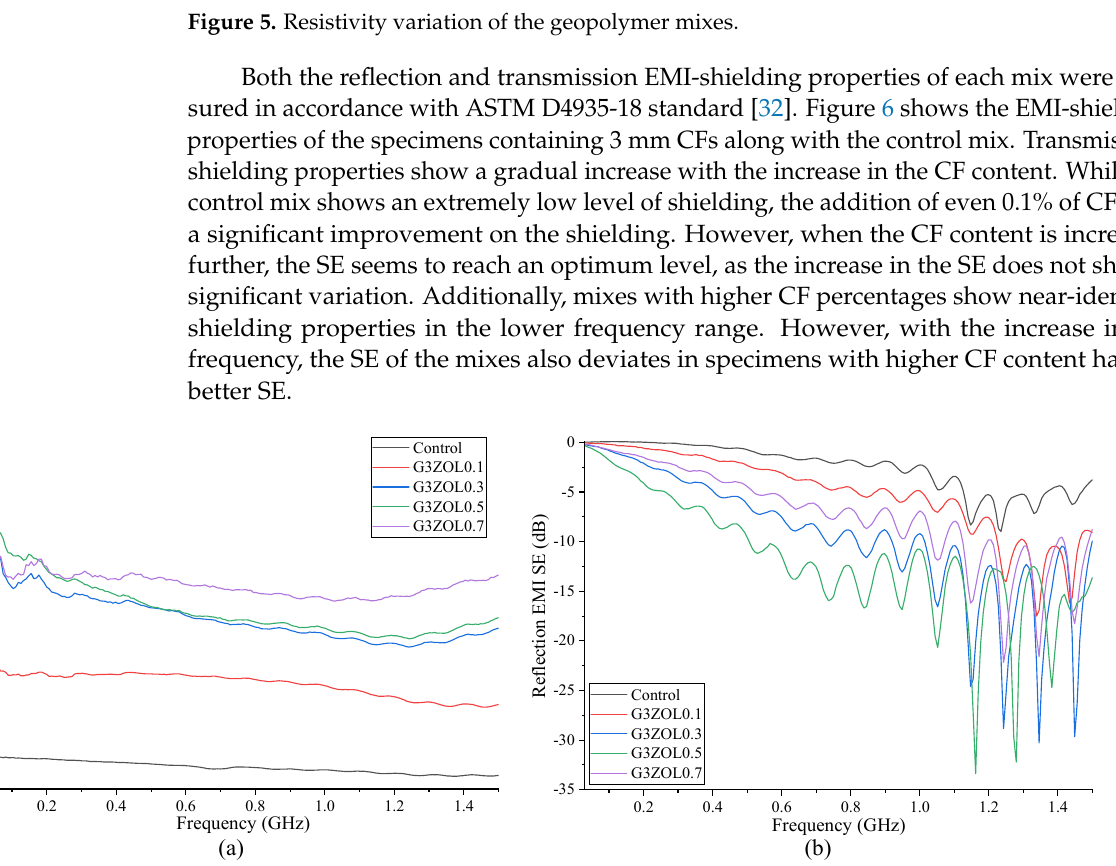
Figure 6. ( a ) Transmission EMI SE containing 3 mm CF; ( b ) reflection EMI SE containing 3 mm CF. Reflection properties show an increase with the CF content up to 0.5% and a decrease with further addition. Generally, the reflection of EM waves from a material is known to take place when the material has a significant level of conductivity and can be influenced by the frequency of the EM waves as well [26,27]. Figure 5 shows that the electrical con-